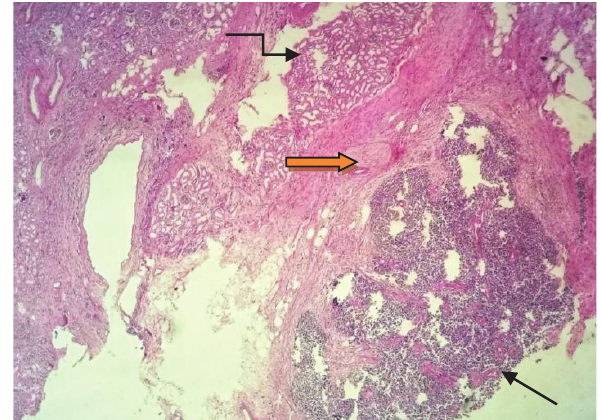
Fig-3: Photomicrograph of H&E staining showing a renal hilum (right arrow), involved by Wilms Tumor (arrow) adjacent normal kidney parenchyma (elbow arrow) X